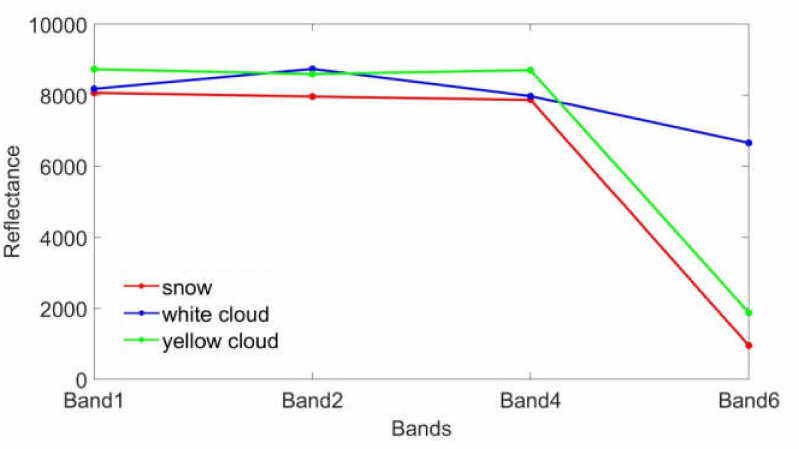
Figure 6. Spectral curves of cloud and